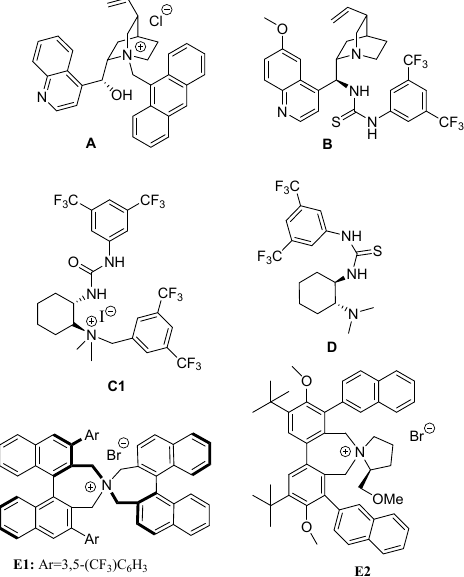
Figure 1. Organocatalysts used in this screening. Table 2. Asymmetric organocatalytic cascade reaction of nitromethane.